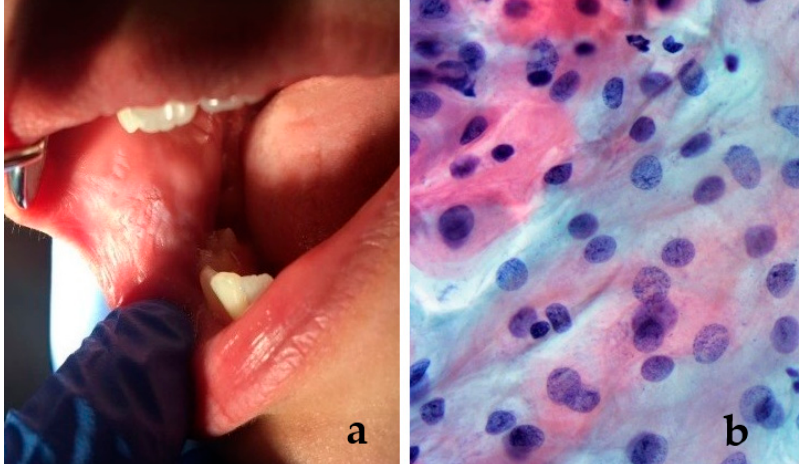
Figure 3. ( a ) A 12-year-old female patient with a white „patch” on the buccal mucosa, resembling leukoplakia; histopathological examination was performed in order to obtain the correct diagnosis; ( b ) exfoliative cytology did not confirm the presence of a premalignant lesion. Intermediate squamous cells (reflecting the accelerate turnover) with slight inflammation (different shape of nuclei, stainability, irregular contour of the nuclear border) (Papanicolaou stain, ×40).